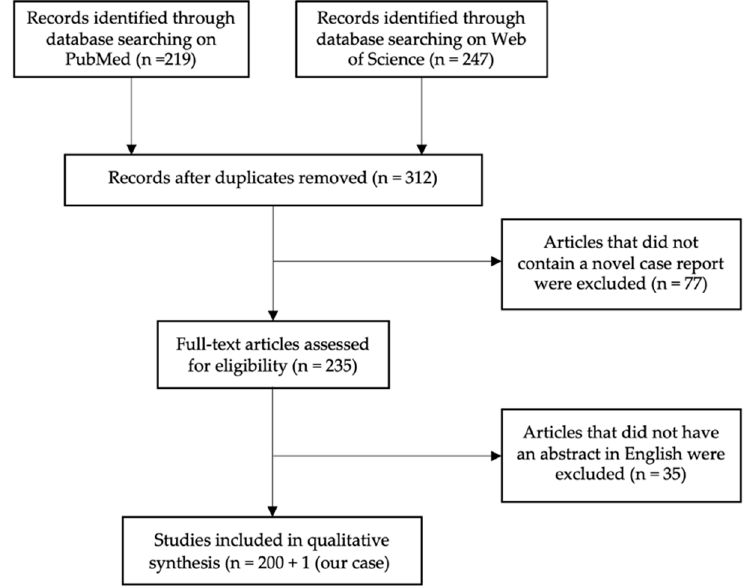
Figure 2. PRISMA Flow Chart visualizing the literature selection process. As database PubMed and Web of Science were used. As keyword “meningeal melanocytoma” was applied. In total, 219 results were found using PubMed and 247 using Web of Science published between the first description in 1972 and 2022. After subtracting duplicates, the total data covered 312 items. A total of n = 77 were excluded because no novel case report of MM was provided, and n = 35 were excluded as no abstract was available in English language. Therefore, in total, 201 published cases, as well as 1 unpublished case from our department, were included for further analysis.